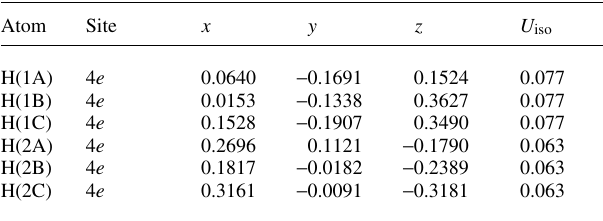
Table 2. Atomic coordinates and displacement parameters (in Å 2 )